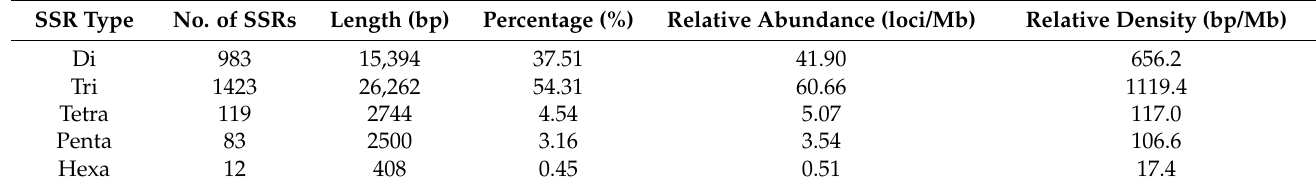
Table 1. Distribution of SSR motifs (di to hexa) with three primer pairs, their relative abundance (loci/Mb) and relative density